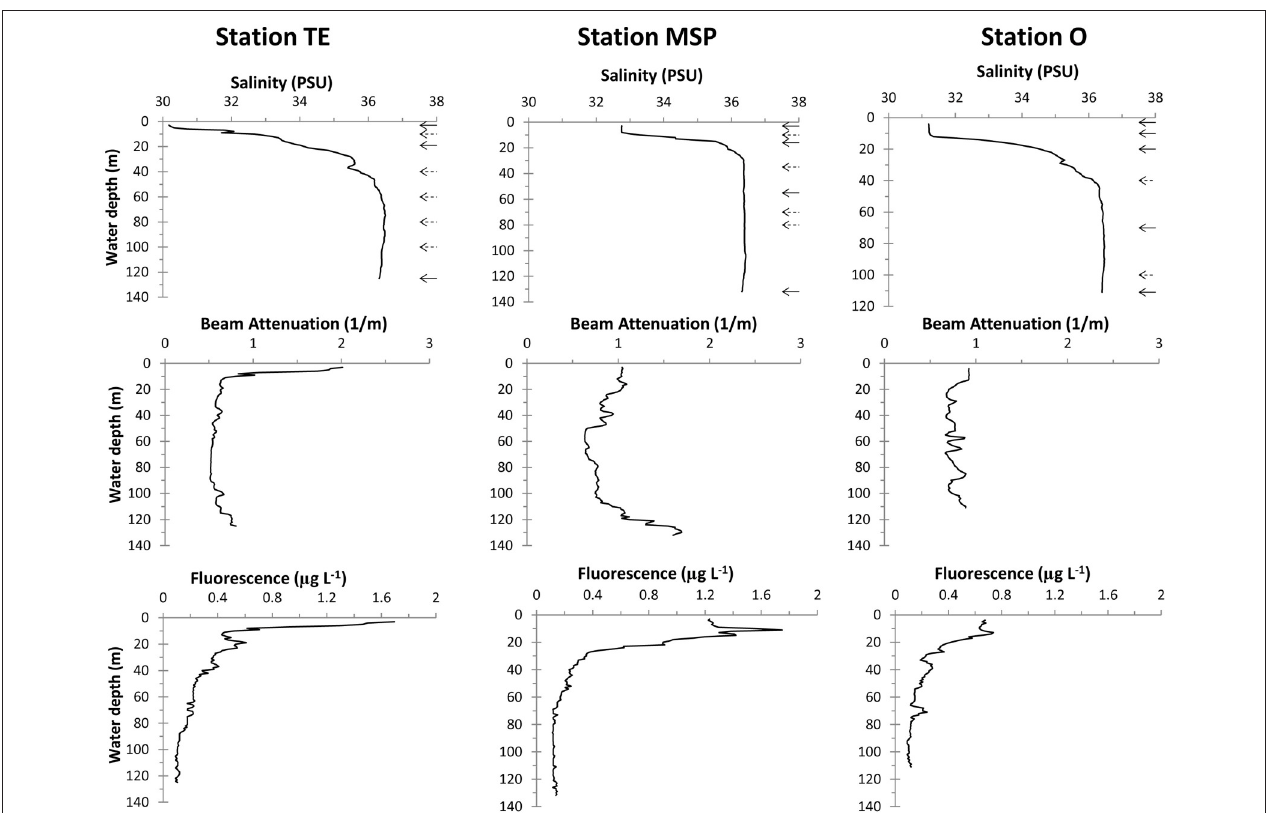
FIGURE 2 | CTD profiles of water column salinity, beam attenuation, and fluorescence. Arrows in the salinity plots indicate the depths of the water column samples (dashed arrows: bacterial community abundance and activities only).